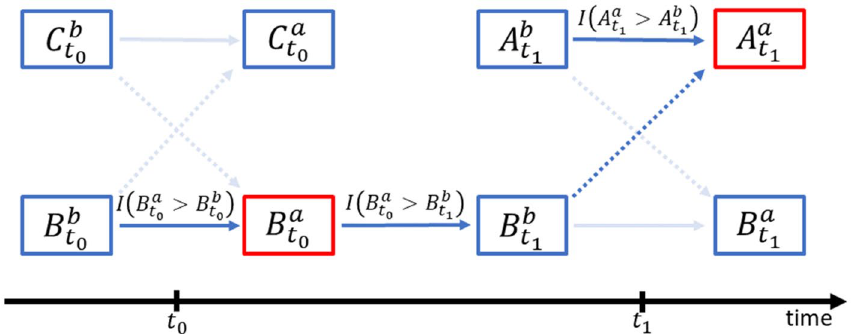
Figure 2. Schematic plot of mood states reported by a triplet of participants A, B and C, in which B and C made a contact at time t 0 before B and A contacted each other at time t 1 within two days. The mood states before and after the contact at time t 1 of participant A are denoted by A mood changes of the participants, either due to a social interaction or just because time passed, are presented by indicator functions as they are marked above solid arrows. The dotted arrows indicate the influence of the contact